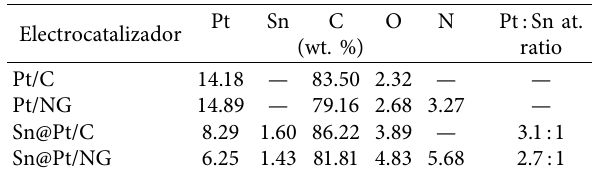
Table 2: Chemical composition of the nanocatalysts by